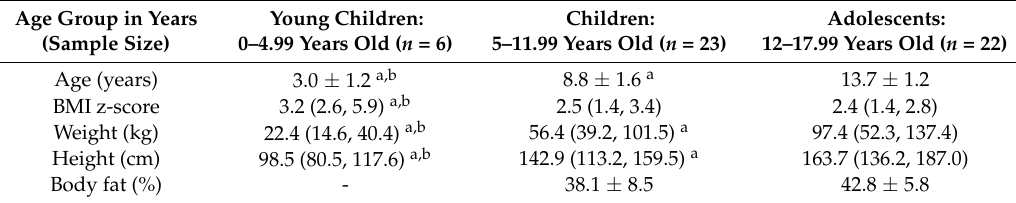
Table 1. Anthropometric characteristics of participants by age